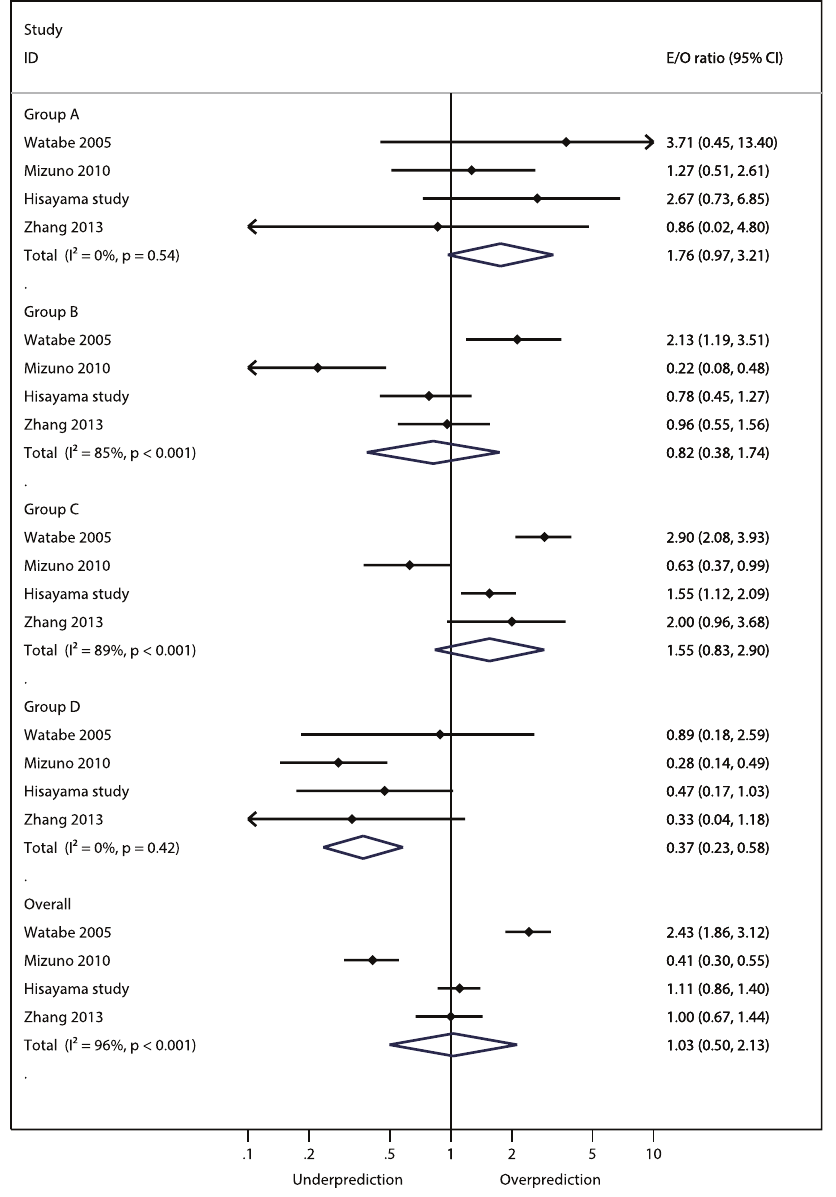
Figure 4. Meta-analysis of the expected over observed (E/O) ratios. The diamonds depict a summary E/O ratio and extending 95% confidence interval (CI). Each closed circle and horizontal line indicates the hazard ratio and corresponding 95% CI, respectively, for each study. Studies are ordered by publication year.